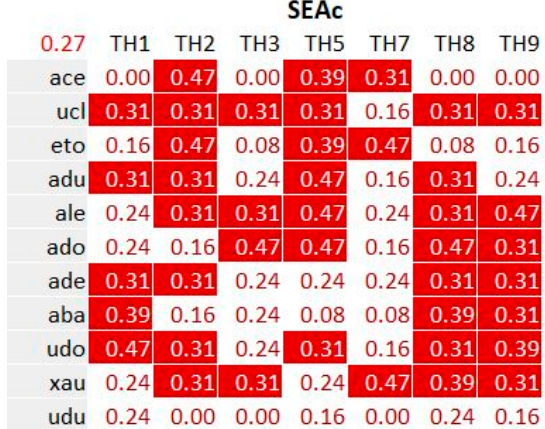
Figure 19. SEAc computes the normalized average value of self-evaluated proximities measured at the beginning and at the end of the experiment; the average value of the whole matrix = 0.27; values above 0.27 appear on a red background.